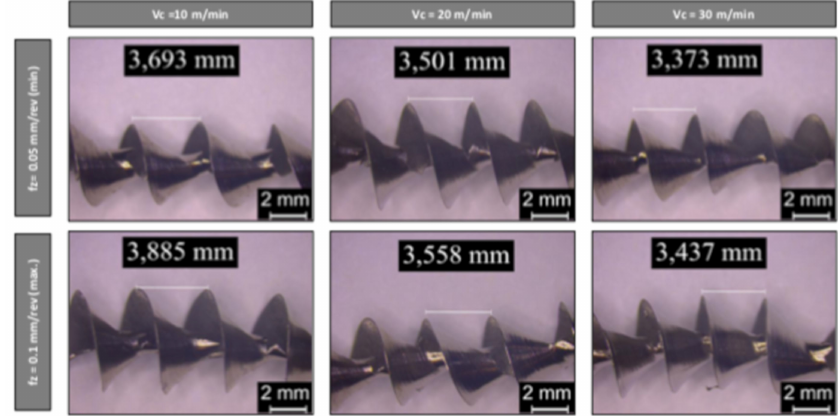
Figure 8. E ff ect of cutting speed and feed rate on the chip “pitch” (workpieces produced by